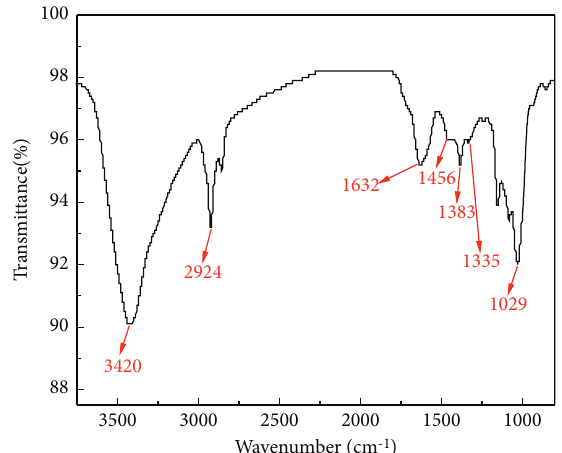
Figure 4: The FT-IR spectrum of the CQDs.